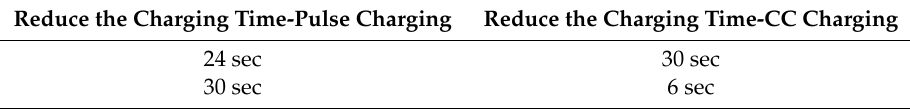
Table 6. Result of the reduction of the charging time by the charging